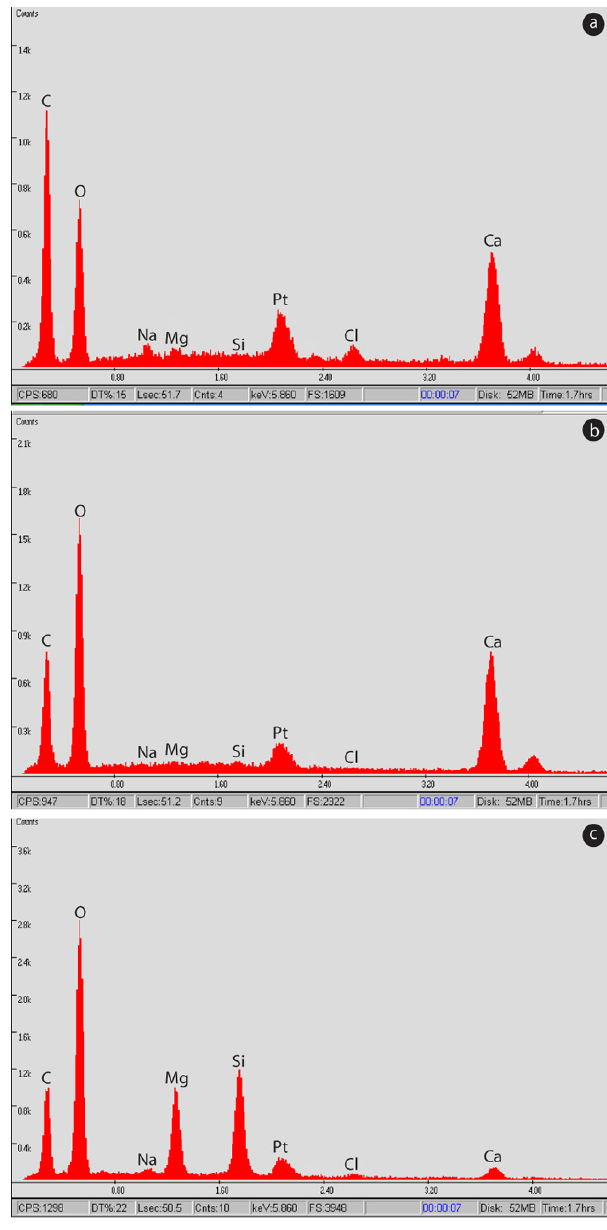
Fig. 4. Elemental analyses using EDAX in the SEM area (Fig. 9f): (a) organic composition of the biofilm as shown by the high C peak; (b) surrounding calcite; (c) biofilm is locally permineralized as Mg-